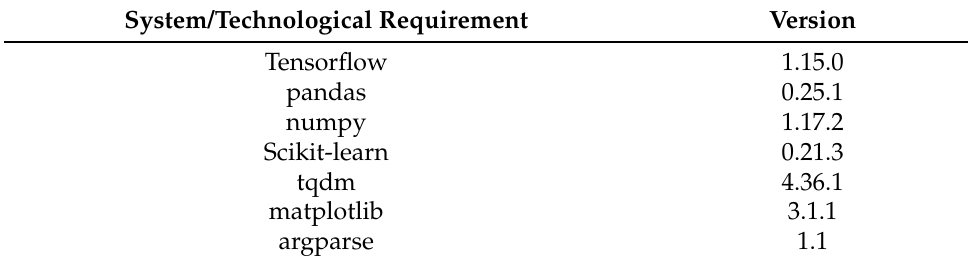
Table 4. System and technological